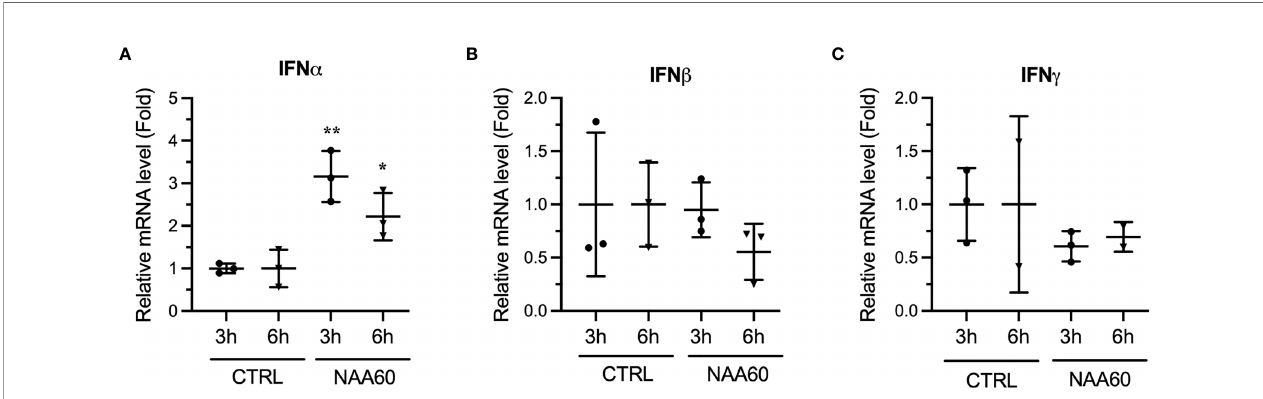
FIGURE 3 | The depletion of NAA60 increases IAV-induced IFN a expression. A549 cells were transfected with 10 nM of CTRL or NAA60 siRNA for 72 h. One set of the cells was processed to con fi rm the depletion of NAA60 by RT-qPCR as in Figure 1A (not shown). The other set of the cells was infected with PR8 at an MOI of 1.0 for 3 h or 6 h, and the cells were processed to detect and calculate the mRNA level of IFN a (A) , IFN b (B), or IFN g (C) by RT-qPCR as in Figure 1A . Error bars represent means ± standard deviation of at least three biological replicates; **P ≤ 0.01, *P